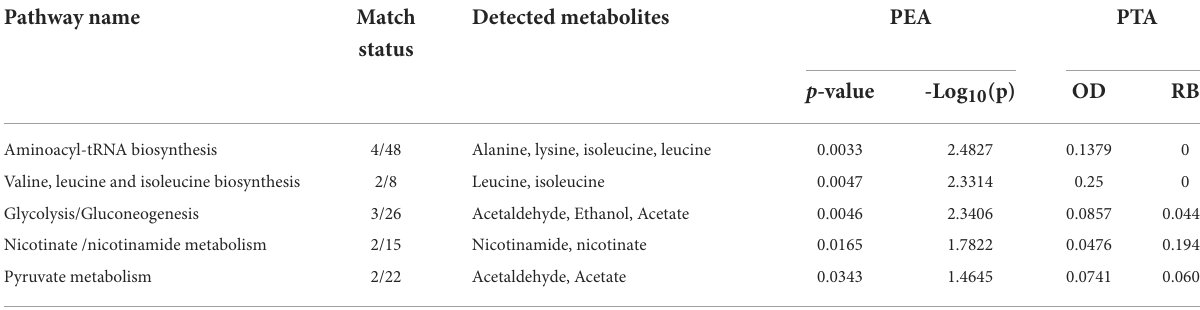
TABLE 4 Significant altered metabolic pathways in patients with MDD compared with healthy subjects ( p < 0.05) using pathway enrichment analysis (PEA) and pathway topological analysis